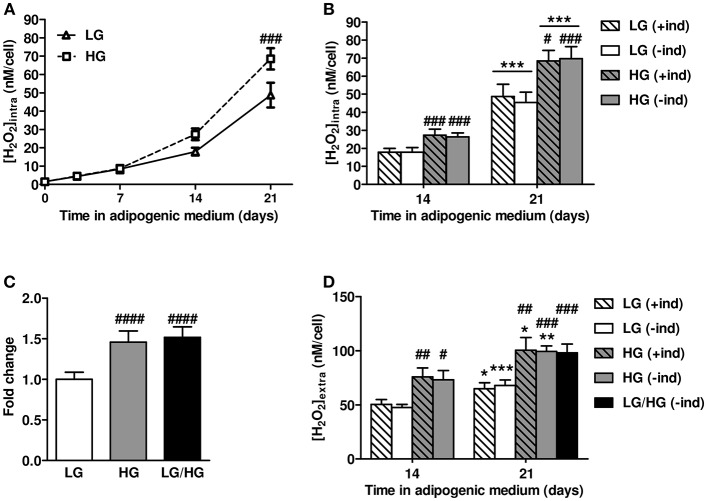
HG level stimulates intracellular and extracellular ROS production by mature BMAds. (A) Kinetics of intracellular reactive oxygen species (ROS) levels examined up to 21 days of BMAd differentiation and maturation under LG or HG concentrations in presence of adipogenic inducers (+ind). Data were obtained from six to nine independents measurements (at least three technical replicates for the two donors) and are expressed as intracellular H2O2 concentration in nM per cell, mean ± SEM. Using two-way ANOVA tests, the effect of time within adipogenic medium was found significant for both glucose concentrations with p < 0.0001; the effect of HG was found significant with p = 0.013 and Bonferroni post-test ###p < 0.001. (B) Comparison of intracellular ROS levels measured at days 14 and 21, under LG or HG conditions, and under continuous stimulation by inducers (+ind) or after their removal 2 days prior to measurements (–ind). Data were obtained from six to nine independents measurements and are expressed as abovementioned with mean ± SEM. ***p < 0.001 compared to values obtained at day 14 for the respective medium composition; #p < 0.05, ###p < 0.001 compared to values obtained in the respective LG condition (using unpaired t-tests). (C) Intracellular ROS levels measured after 21 days in LG or HG concentrations or after 11 days in HG (LG/HG) following adipogenic inducer removal 2 days prior measurements (–ind). Data were obtained from eight to fourteen independents measurements, expressed as fold change compared to the LG condition, and are mean ± SEM. ####p < 0.0001 compared to LG condition (using unpaired t-tests). (D) Extracellular ROS levels assessed at days 14 and 21 in adipogenic medium, under LG, HG, or LG/HG conditions, with continuous stimulation by inducers (+ind) or after their removal 2 days before measurements (–ind). Data were obtained from four independents measurements from the two donors and are expressed as extracellular H2O2 concentration in nM per cell, mean ± SEM. *p < 0.05, **p < 0.01, ***p < 0.001 compared to values obtained at day 14 for the respective medium composition; #p < 0.05, ##p < 0.01, ###p < 0.001 compared to values obtained in the respective LG condition (using unpaired t-tests).